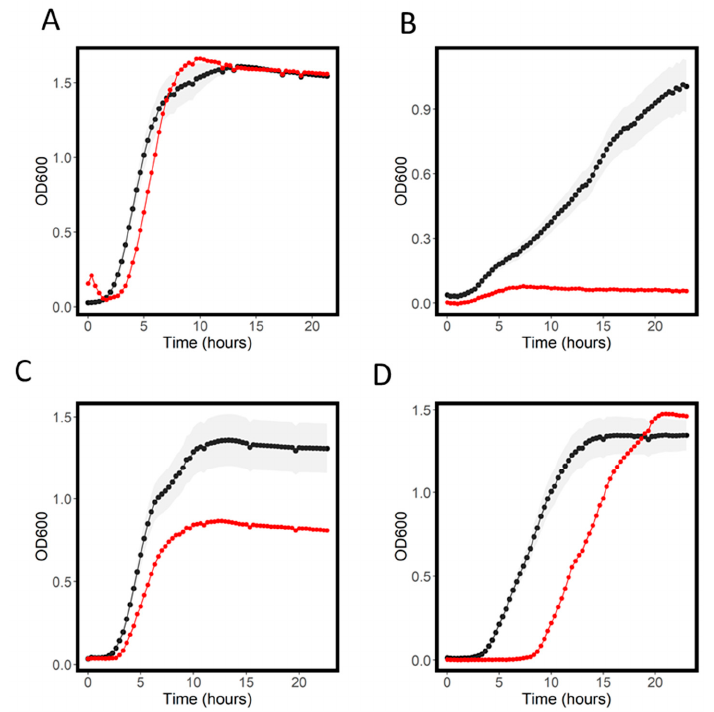
Figure 4. Growth curves for WT (black) and ∆ acrB (red) in LB ( A ), azithromycin, ( B ) D-cycloserine ( C ) and chloramphenicol ( D ). Shaded areas represent the standard deviation for the WT growth curve.